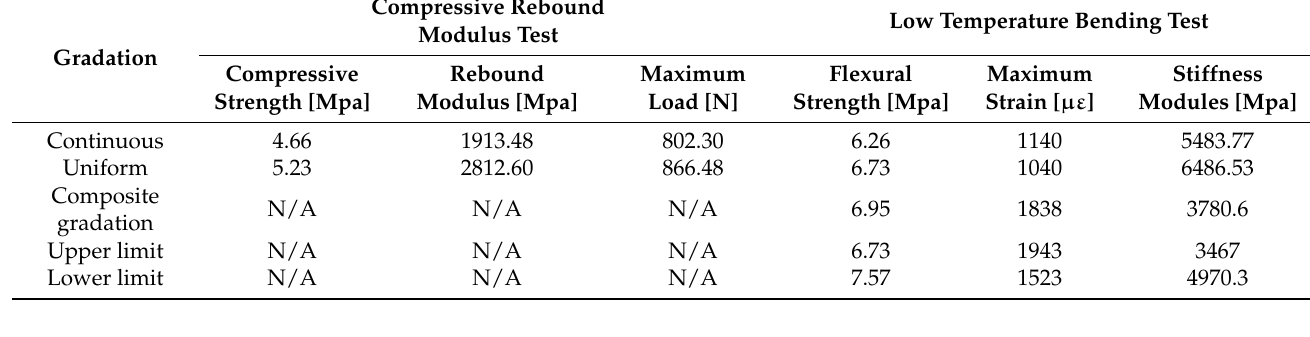
Table 4. Effects of gradations on physical properties of GSP [48,49].